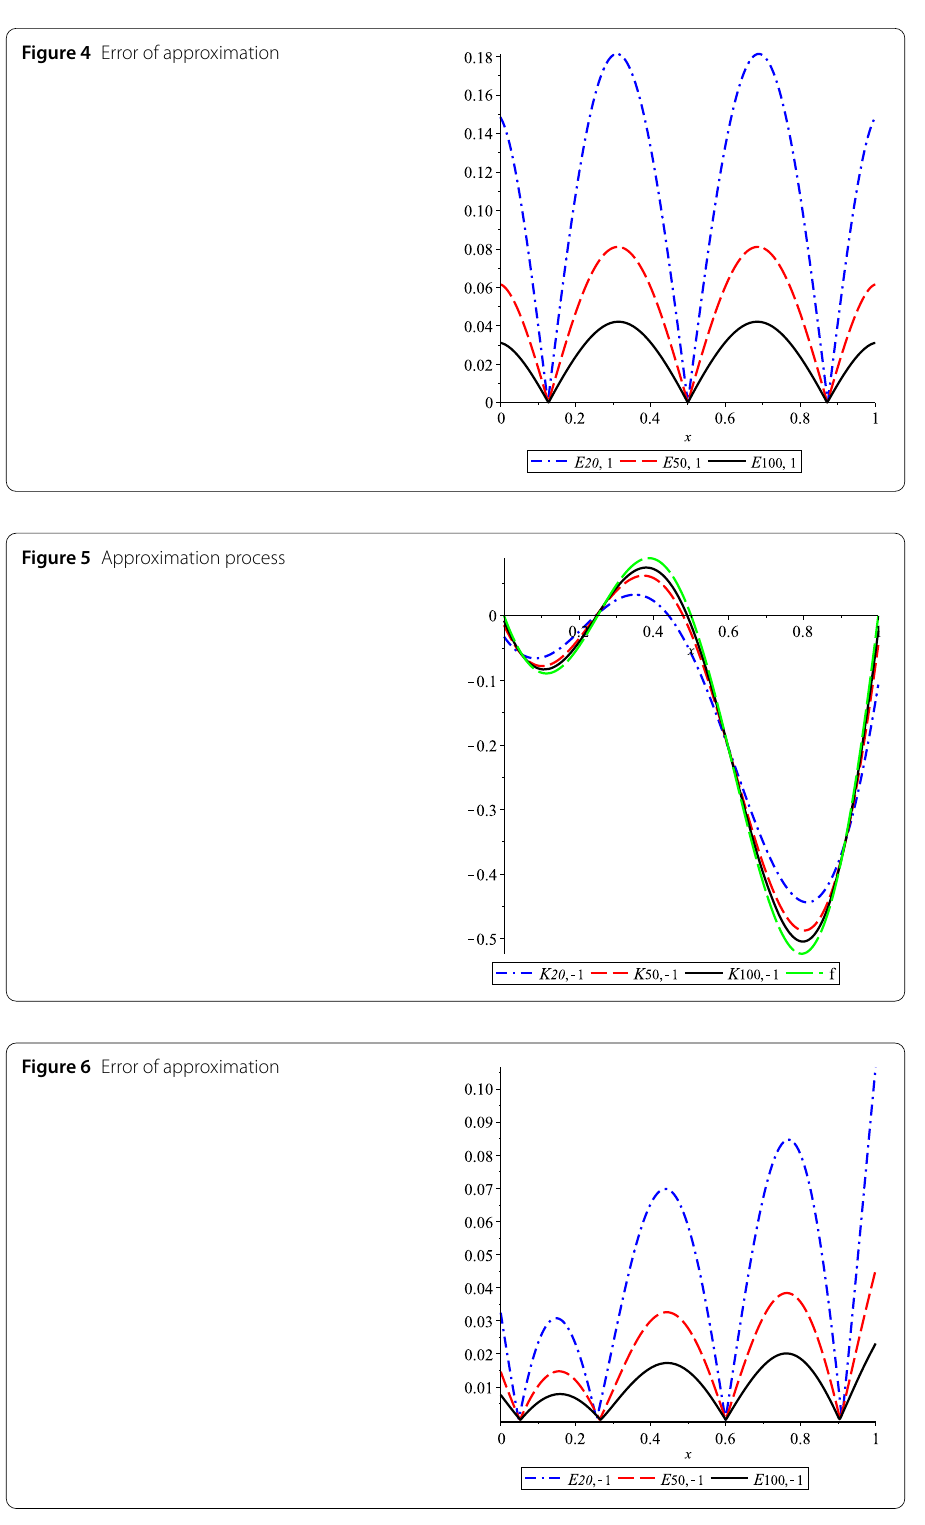
Figure 6 Error of